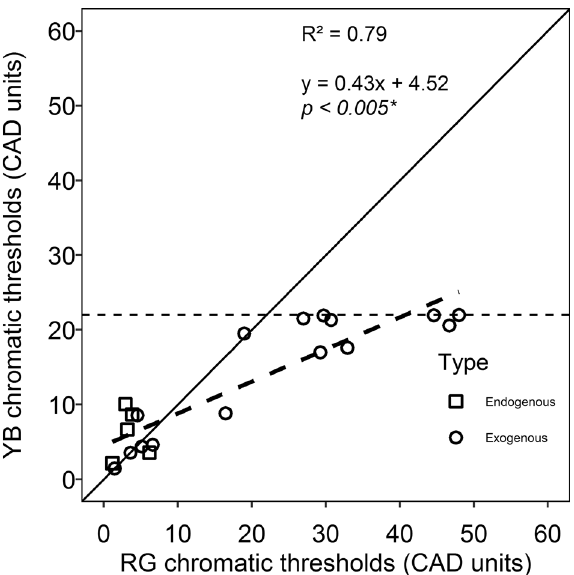
Figure 3. Scatterplots of YB thresholds against RG thresholds. The solid line indicates the line of equality. The dotted line show the regression line fitted by a linear function whose equation is provided. The horizontal dashed line indicates the maximum YB threshold that can be measured using the